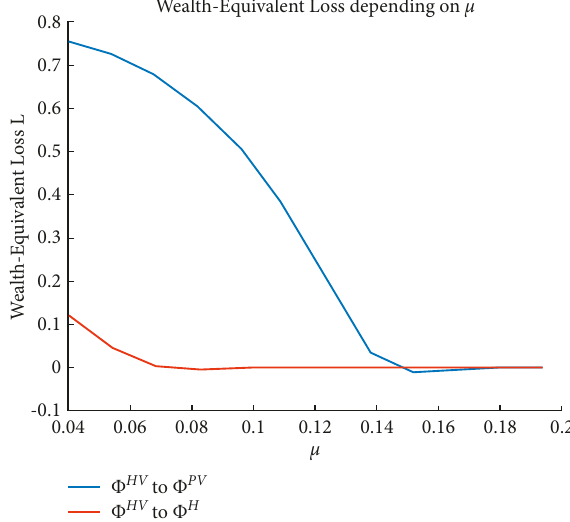
Figure 5: Wealth-equivalent loss sensitivity to ϵ